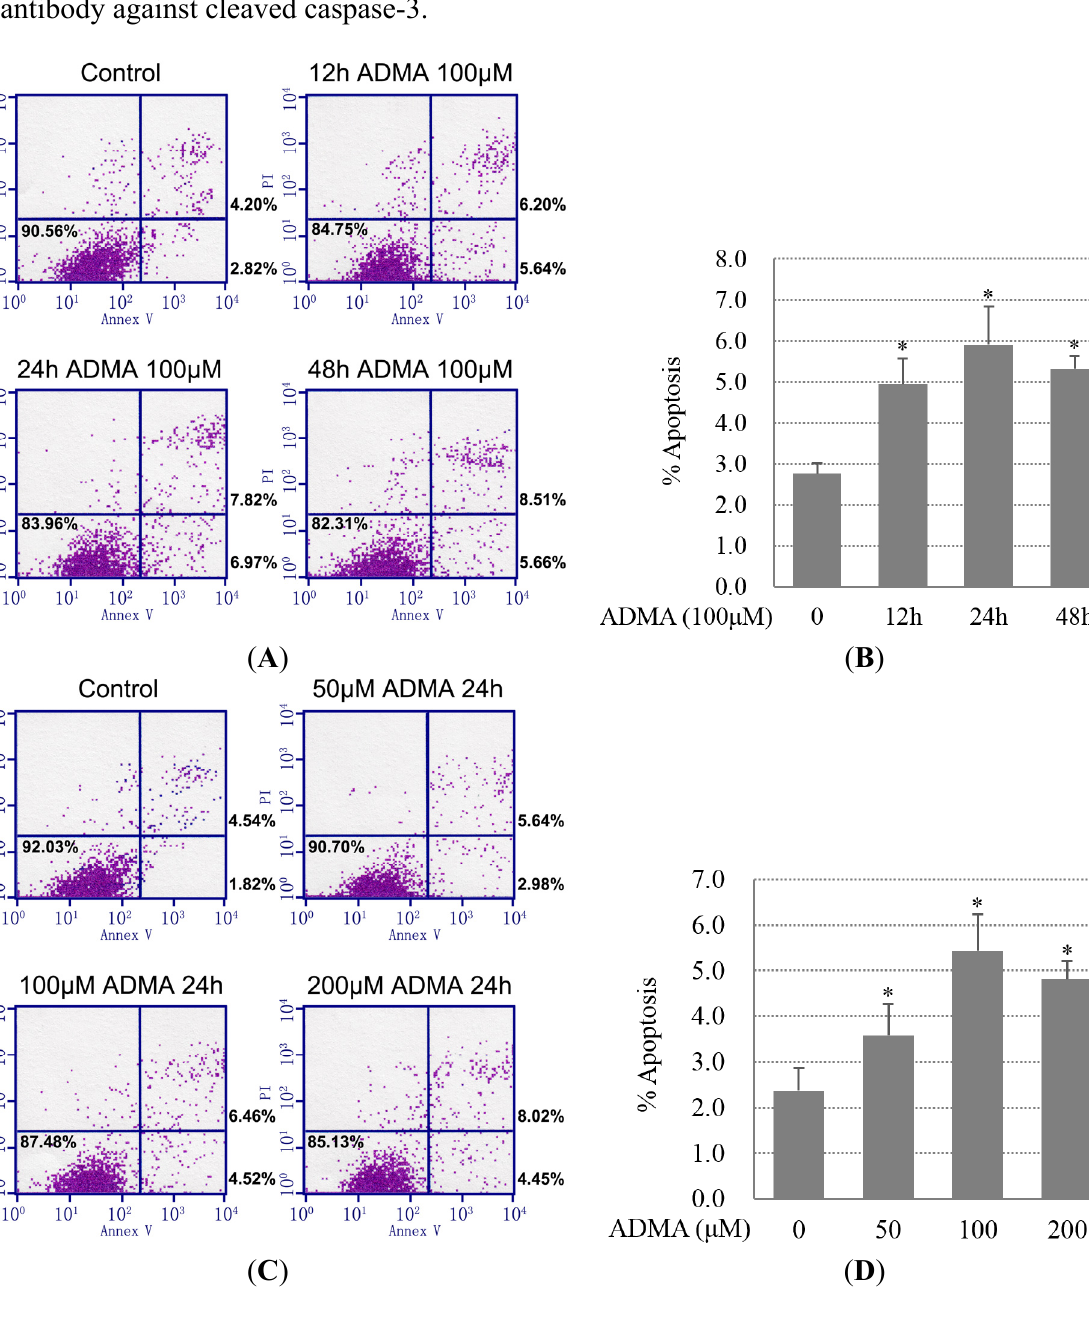
Figure 1. Asymmetric dimethylarginine (ADMA) induced glomerular endothelial